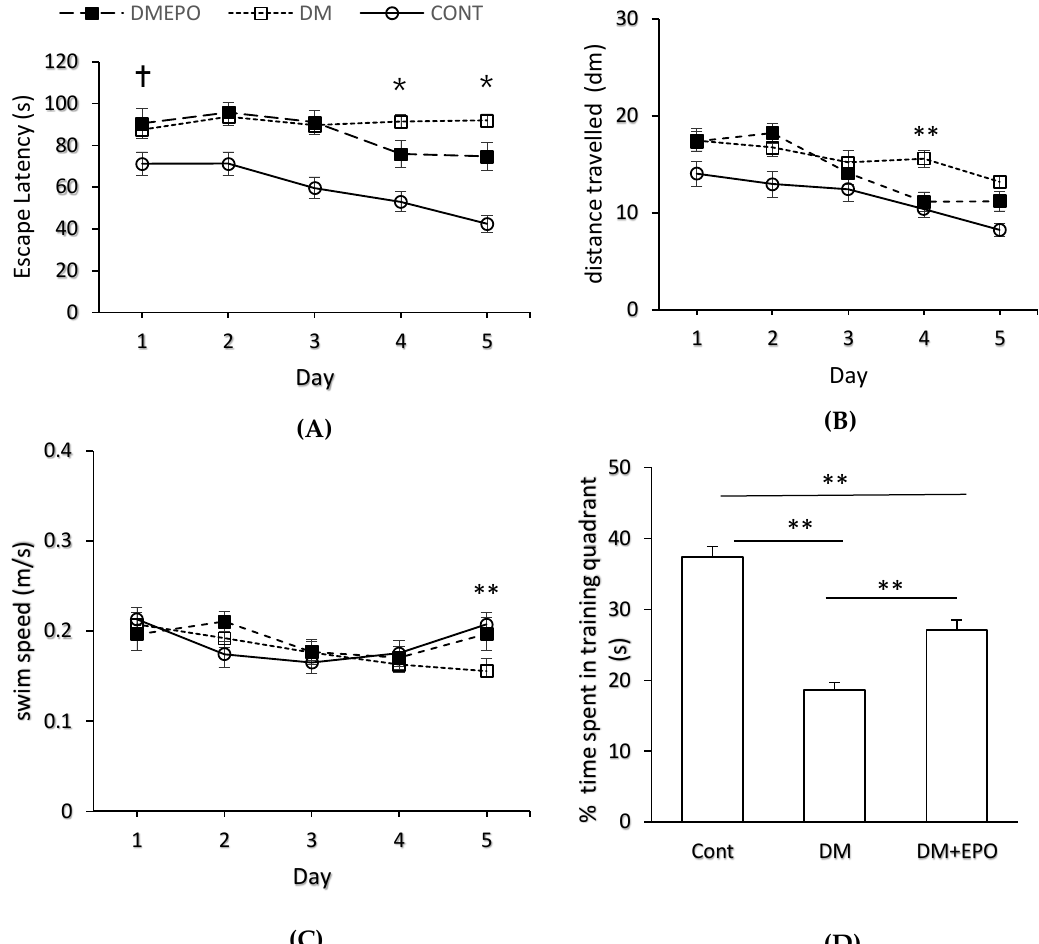
Figure 1. Morris water maze learning in control (Cont), diabetic (DM) and EPO-treated diabetic (DM+EPO) mice. Escape latency ( A ), distance swum to reach the platform ( B ) and swimming velocity ( C ) were measured across the 5 days of the trial. † Ten weeks of diabetes was associated with an increase in latency ( p = 0.01) and distance swum ( p = 0.02) by diabetic animals (with or without EPO supplementation) on day 1 compared to controls. * On day 4 and day 5, latency was